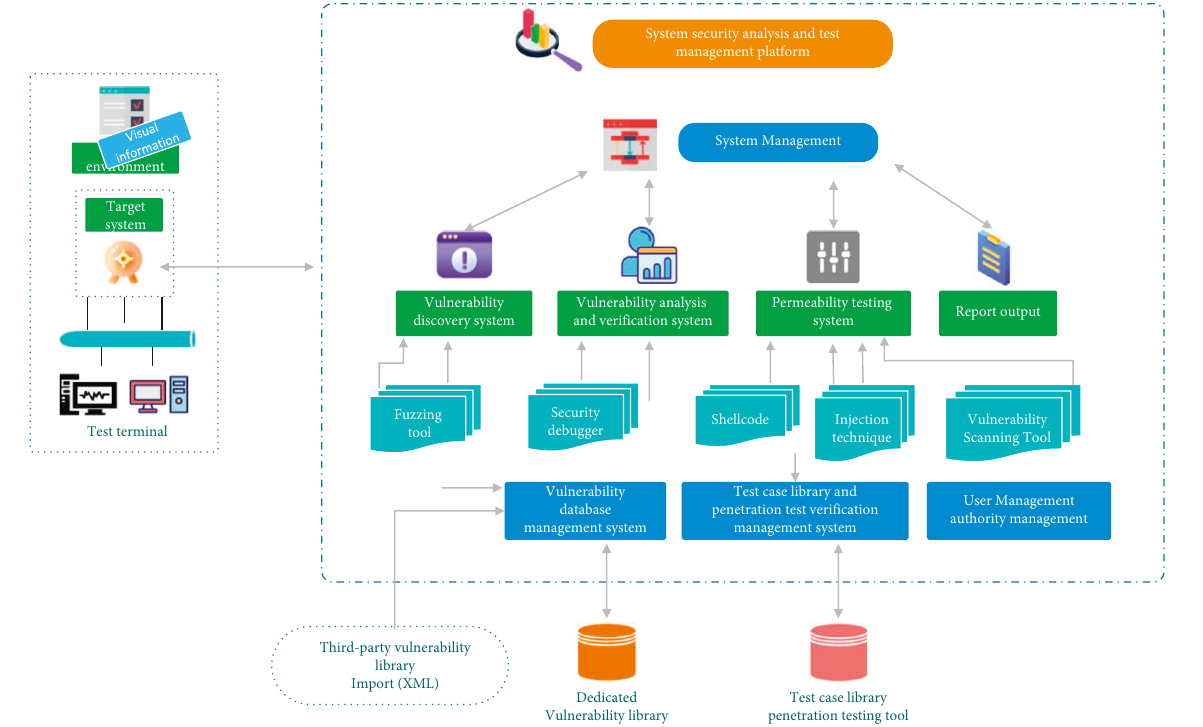
Figure 1: Flowchart of network security vulnerability